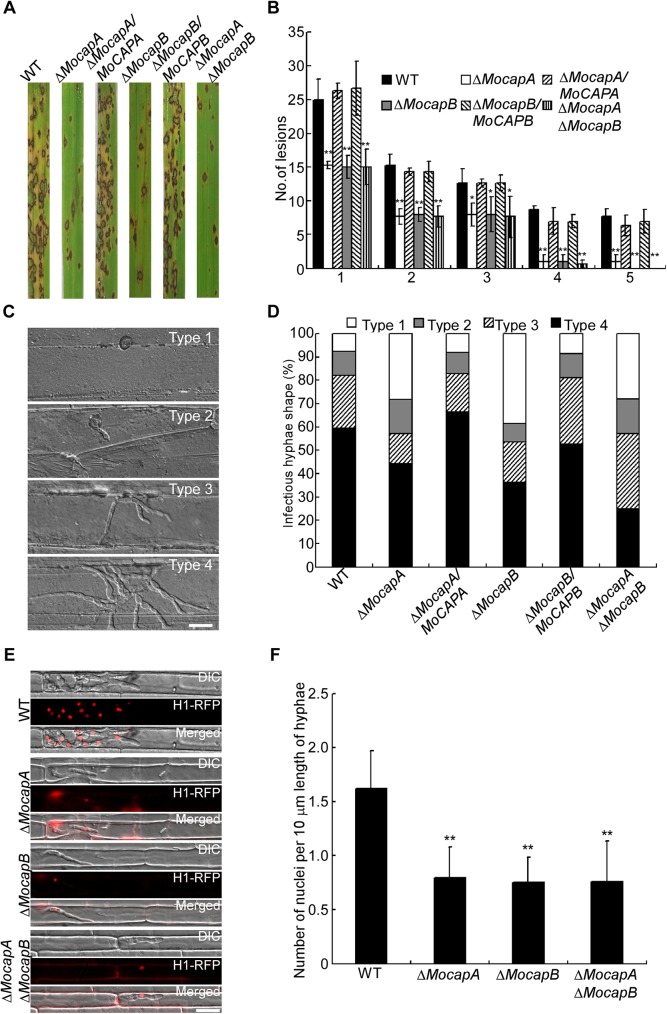
MoCAP proteins are important for full virulence.(A) Rice (Oryza sativa cv.CO39) seedlings were inoculated by conidial suspension. Typical leaves were photographed at 7 dpi. (B) Quantification of lesion type (0, no lesion;1, pinhead-sized brown specks; 2, 1.5-mm brown spots; 3, 2–3-mm grey spots with brown margins; 4, many elliptical grey spots longer than 3 mm; 5, coalesced lesions infecting 50% or more of the leaf area). The n means the number of lesions on three rice leaves. Lesions were photographed and measured or scored at 7 days post-inoculation (dpi) and experiments were repeated twice with similar results. Error bars represent the SD and double asterisks indicate statistically significant differences (**, p<0.01) and one asterisk represent statistically significant differences (*, p<0.05). (C) Close observation of infectious growth on barley. Excised barley leaves from 7-day-old barley seedlings were inoculated with conidial suspension (5 x 104 spores/ml of each strain). Infectious growth was observed at 24 h post-inoculation (hpi). After incubation with the spore suspensions for 24 h, four types (type 1, no penetration; type 2, only with a penetration peg or a single invasive hypha length shorter than 10 μm with no branch; type 3, invasive hyphae length was about 10–20 μm with 1–3 branches; type 4, invasive hyphae length was longer than 20 μm and/or with more than 3 branches) of invasive hyphae were observed in barley tissues [40]. (D) Statistical analysis for each type of infectious hyphal shape, for each tested strain; 100 infecting hyphae (n = 100) were counted per replicate and the experiment was repeated three times. (E) Live-cell imaging at 36 hpi of Guy11 H1:RFP and ΔMocap H1:RFP strains infecting rice leaf sheaths showed ΔMocap H1:RFP strains were impaired in nuclear proliferation in epidermal cells compared to Guy11 H1:RFP. (F) The mean number of nuclei in 10 mm lengths of IH was calculated and the experiment was repeated three times. (**, p<0.01), n = 100. Bar = 10 μm.